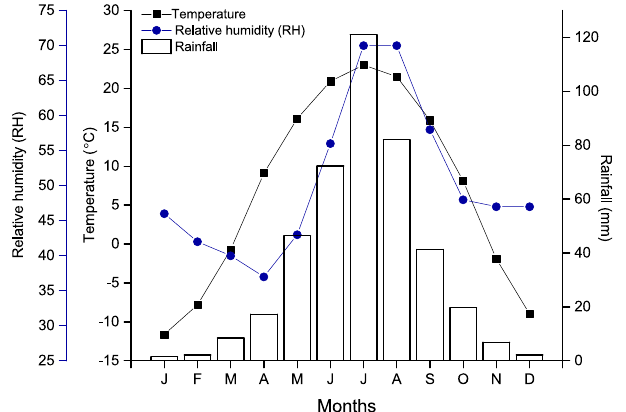
Figure 1. Monthly average temperature, relative humidity and rainfall recorded in the study site between 1986 and